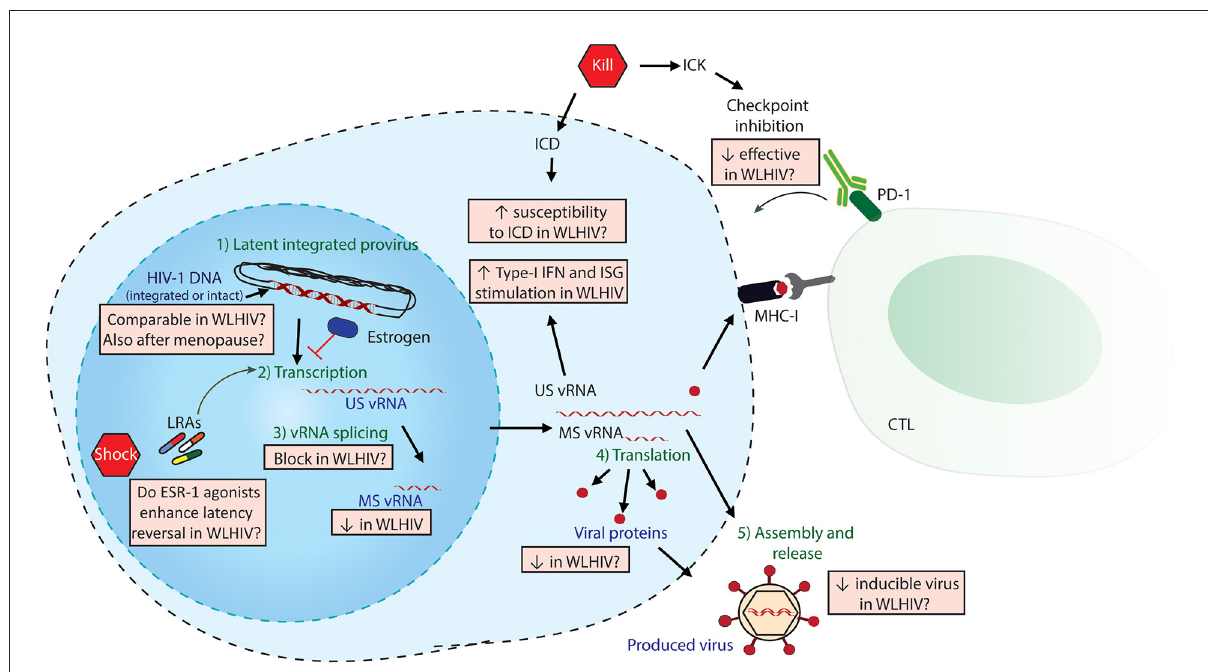
FIGURE1 Sex-specific differences in HIV-1 Shock and Kill. The latent HIV-1 provirus needs to undergo multiple steps (in green) to effectively produce virus. Viral quantitation techniques measure different stages of latency reversal (in purple), including HIV-DNA, cell-associated HIV-1 vRNAs (both unspliced US and multiply spliced MS) and released viral protein or vRNA. The steps of the shock and kill approach are indicated in red pentagons: latency reversing agents (LRAs) to reactivate the provirus, followed by either induced cell death (ICD) or immune-mediated killing (ICK) strategies. ICK strategies may include checkpoint inhibition to enhance cytotoxic T-cell lymphocyte (CTL)-mediated killing. The multiple sex-specific differences, both reported and speculated, are depicted in orange